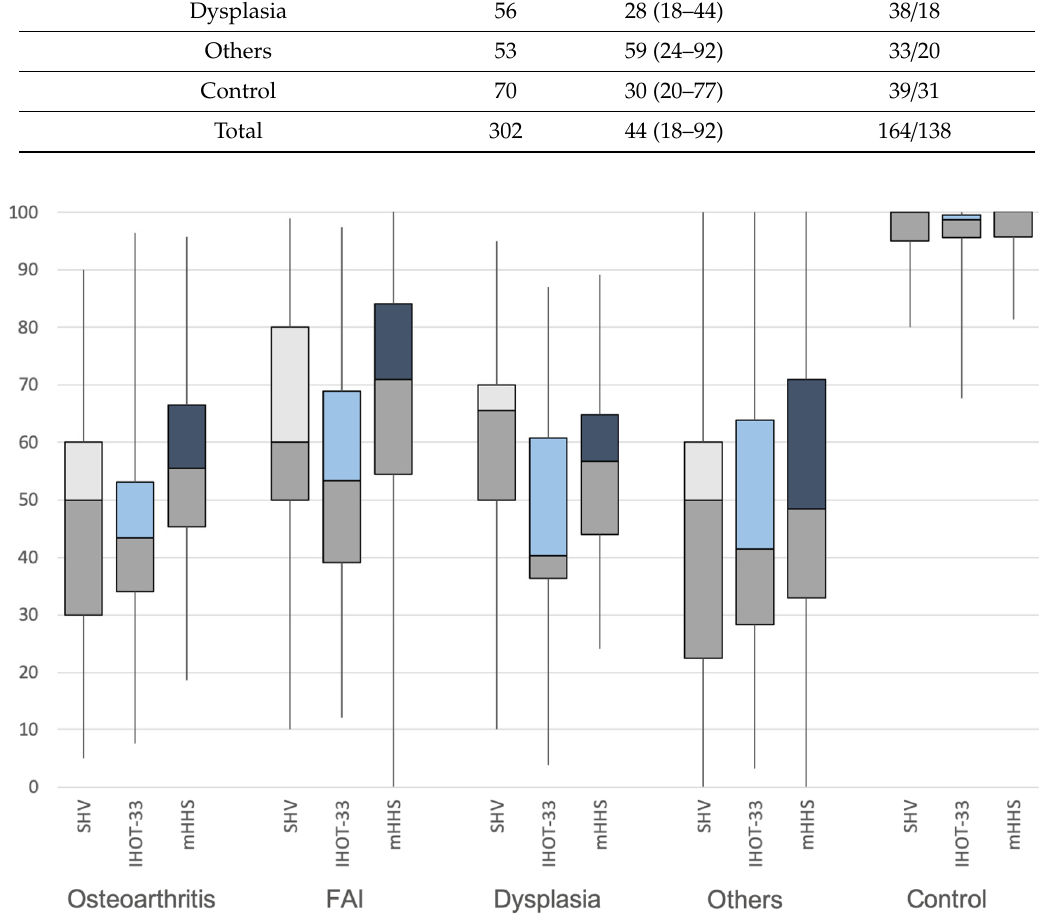
Figure 1. Patient-reported outcome measurement results in the different groups.